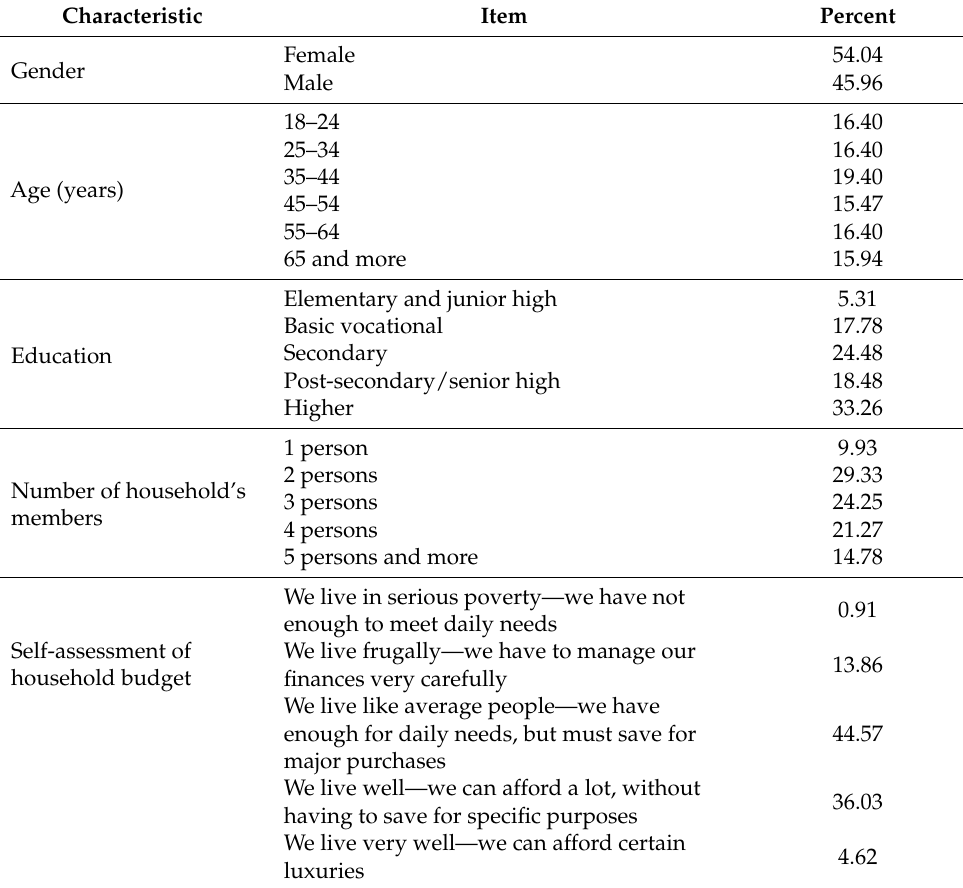
Table 5. Respondents sample